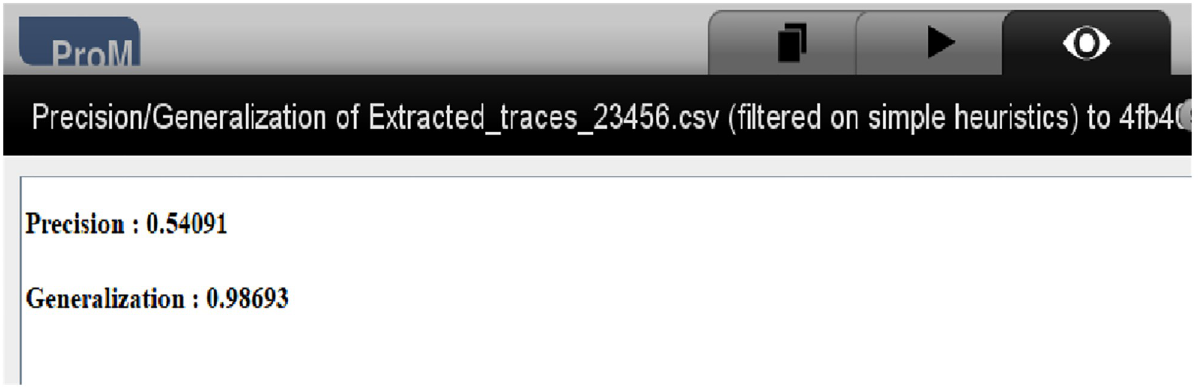
Fig 17. Precision and generalization results of Petri net based on inductive miner.